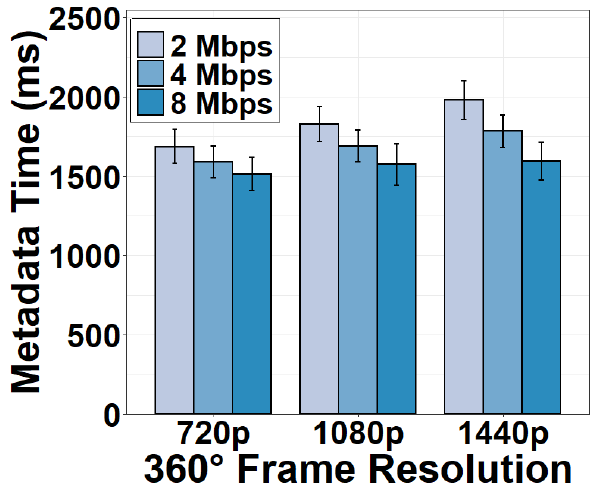
Figure 14. Metadata gen. and tx time under different download